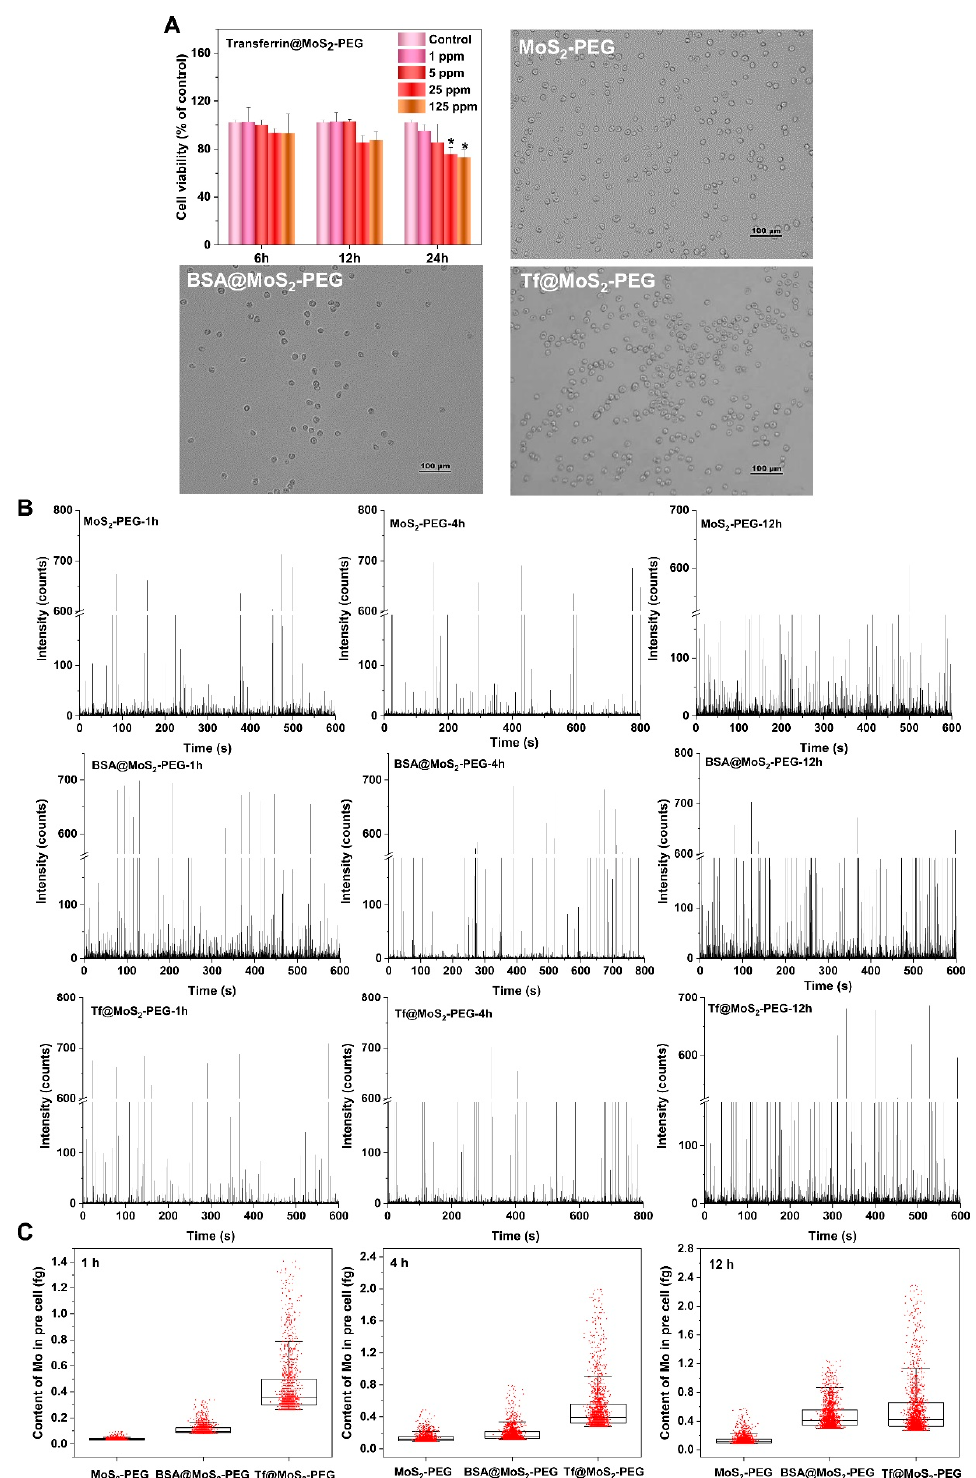
Figure 4. ( A ) Effect of transferrin@MoS 2 -PEG on cell viability after treatment with 1, 5, 25, and 125 µ g/mL for 6, 12, and 24 h and microscopy images of intact and dispersed HepG2 cells after treatment with 10 µ g/mL transferrin@MoS 2 -PEG for 12 h in ultrapure water after immobilization with 70% v / v methanol. * p < 0.05 vs. the control. ( B ) The spectra of SC-ICP-MS measurement of 95 Mo in individual HeLa cells (cell density = 2 × 10 5 cells/mL). ( C ) Box plot for the contents of Mo in single HepG2 cell after treatment of 10 µ g/mL MoS 2 -PEG, BSA@MoS 2 -PEG, and Tf@MoS 2